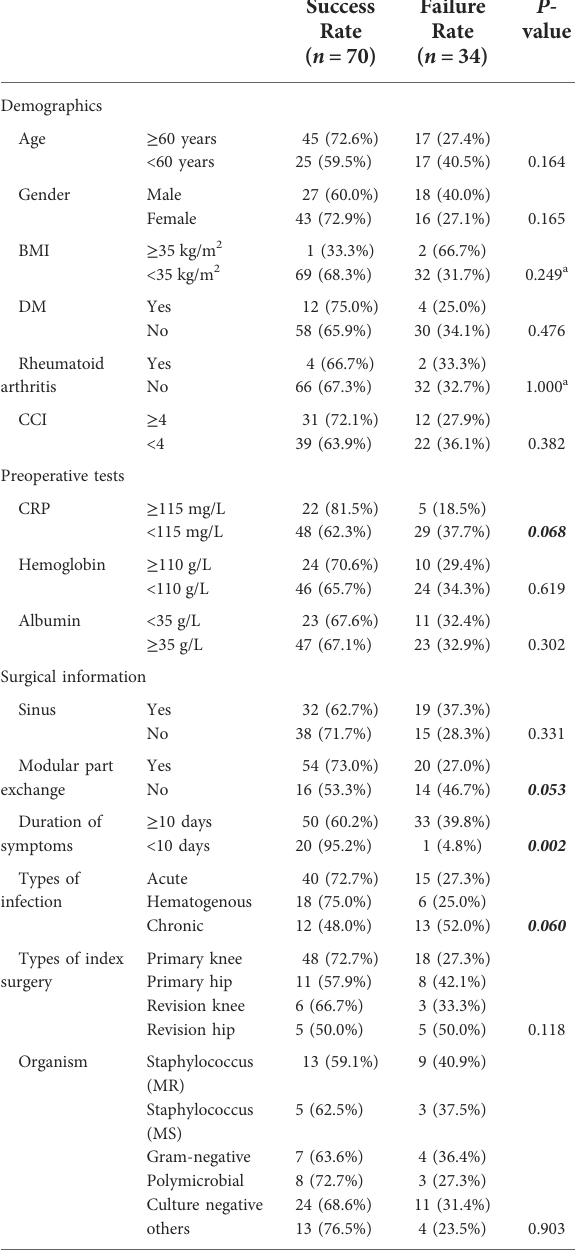
TABLE 2 Comparison of demographics, medical, surgical information and culture results with a univariate analysis.